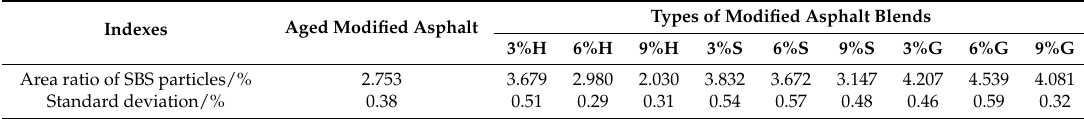
Table 9. Phase characteristics of modified asphalt